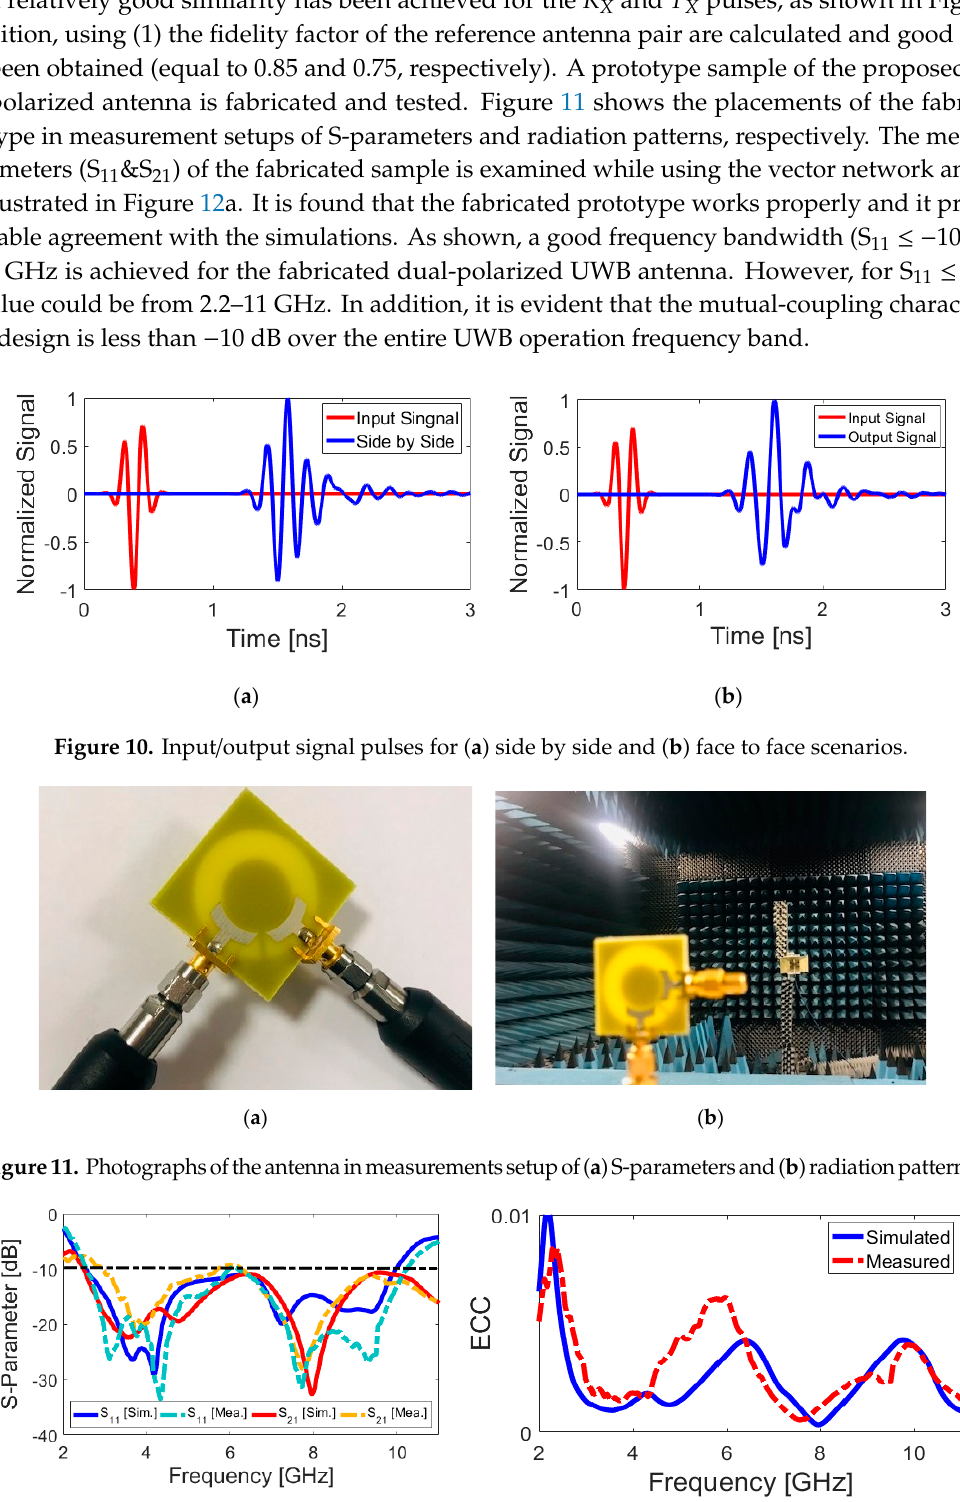
Figure 9. ( a ) Radiation/total efficiencies, maximum gain and ( b ) diversity results of the diversity antenna.